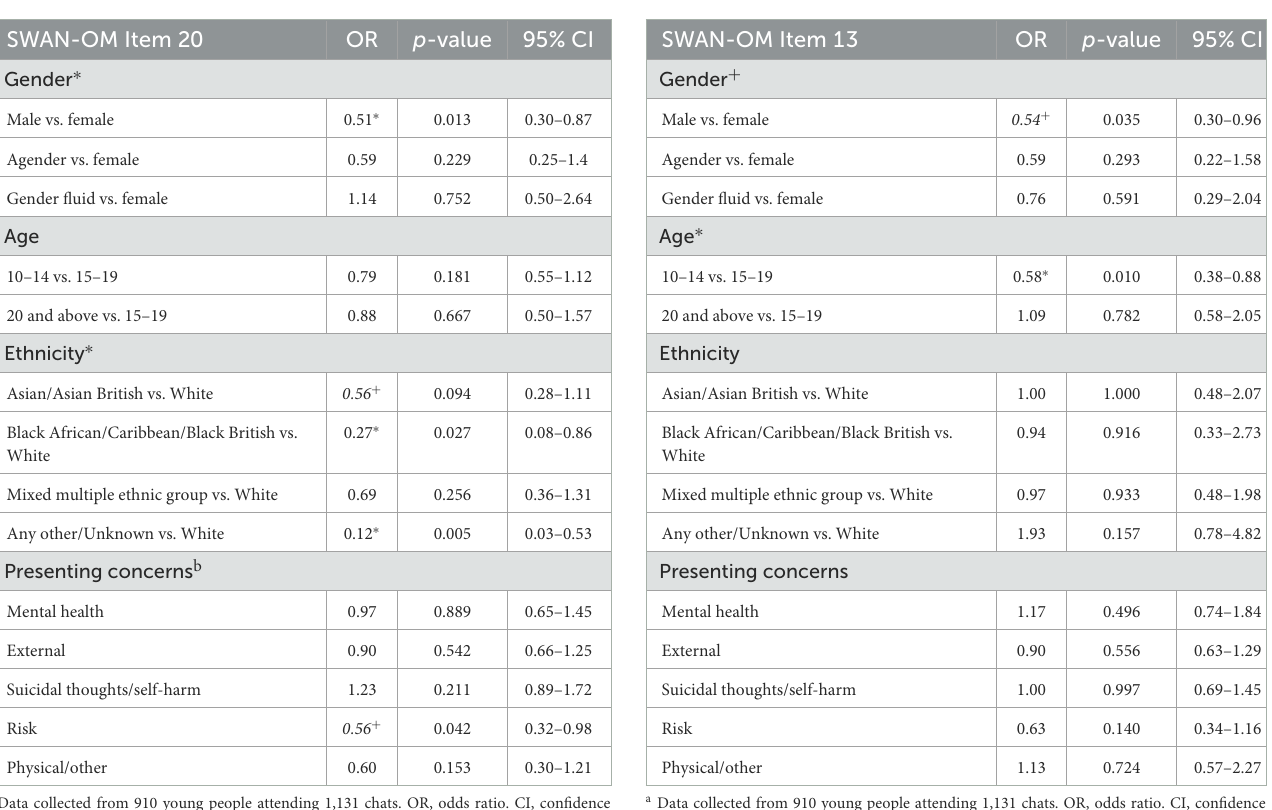
TABLE 3 Results of the hierarchical multi-level logistic regressions for SWAN-OM Item 20: “Find ways I can help myself” a .